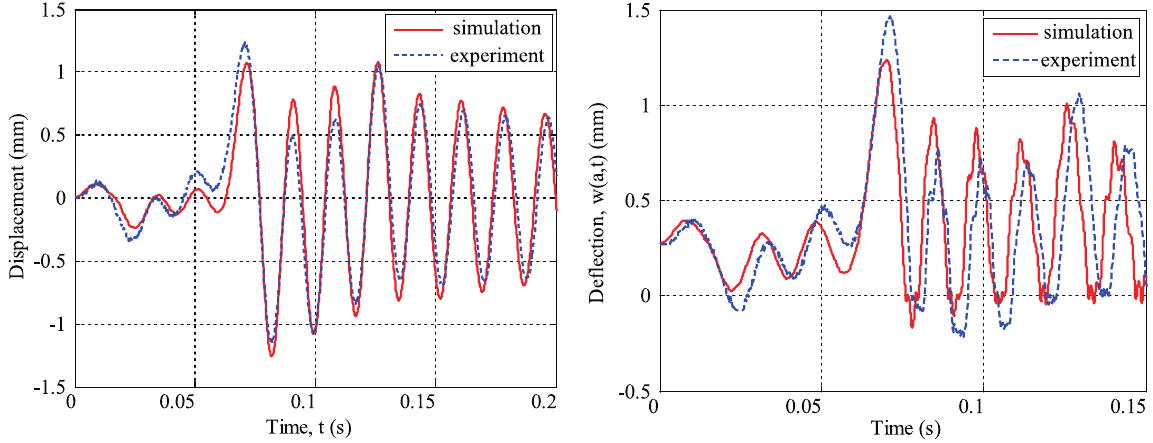
Fig. 7. Comparison of experimental and numerical results for Case 12. Fig. 8. Comparison of experimental and raw numerical results for Case